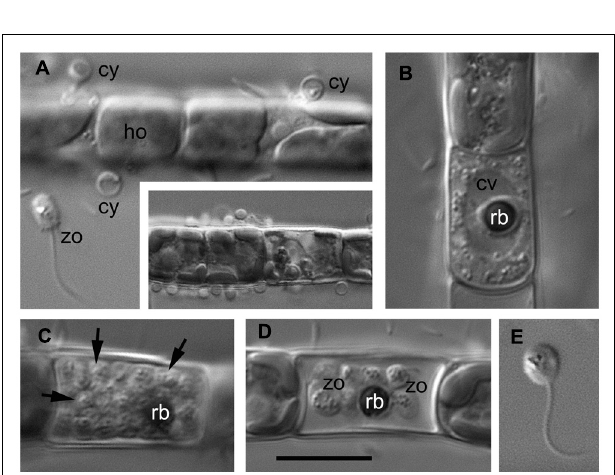
FIGURE 2 | Generalized life cycle of aphelids. Aphelidium (Aph), Amoeboaphelidium (Am) and Pseudaphelidium (Ps), distinguished by zoospore structure and development. (A) Zoospore encystment (c) on the host surface, (B) propagule penetration into the host, (C) trophic amoeba with nucleus (blue) and residual body (red) engulfs host cytoplasm, (D) multinuclear plasmodium (yellow) totally replaced the host, contains several nuclei (blue) and central vacuole with residual body (red), (E) plasmodium divides producing uninuclear cells, (F) mature zoospores released from the empty host cell, (G) precursory stage to the resting spore with nuclei in the center, (H) resting spore with ejected residual body. Dotted line shows conceivable way from resting spore to divided plasmodium. Colors: green, host (alga) cytoplasm; yellow, parasitoid cytoplasm; blue, nucleus; red, residual body.